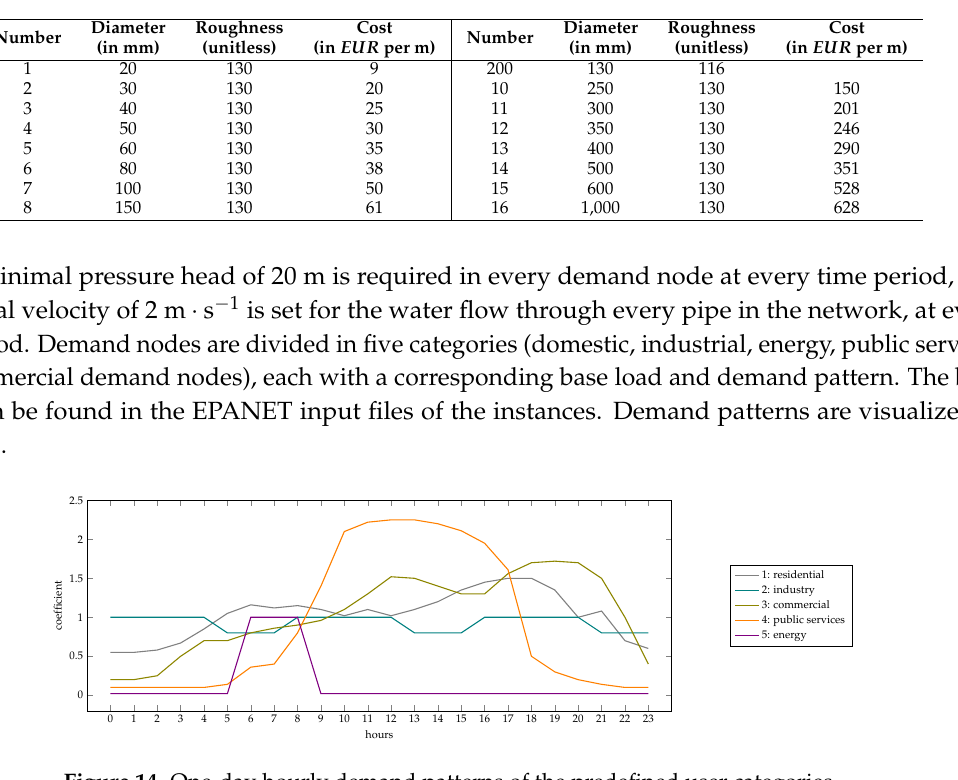
Table 4. Available pipe types and their corresponding costs.